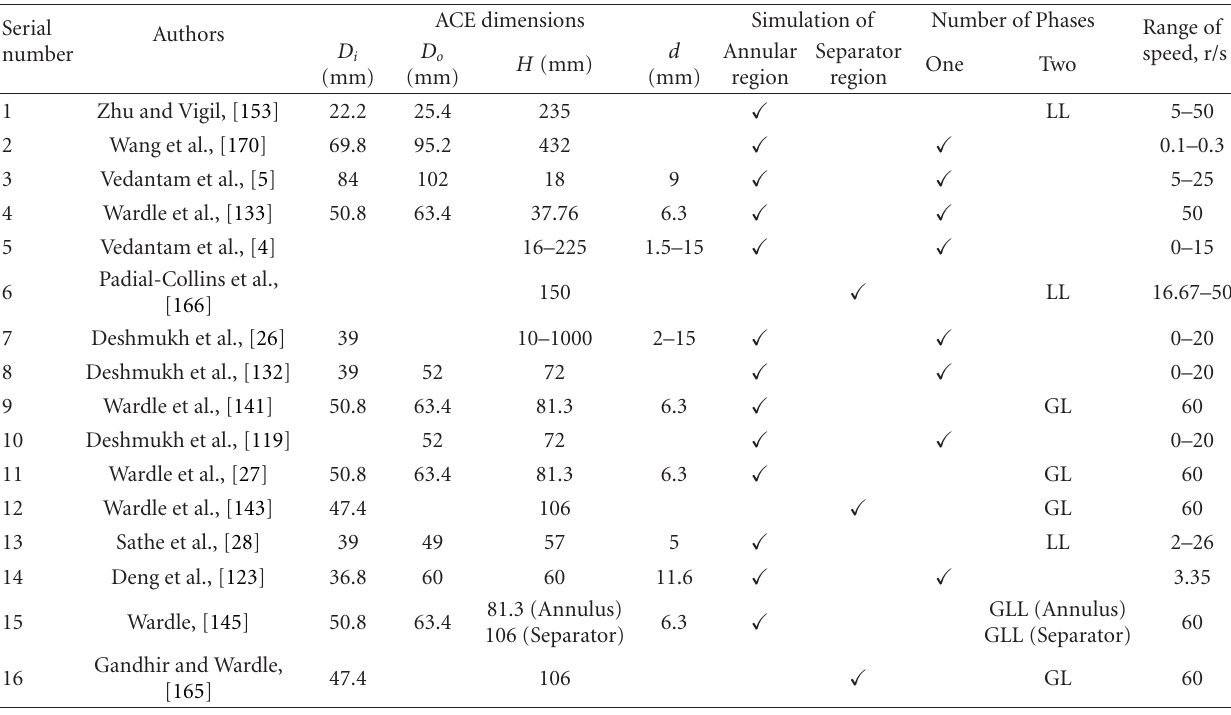
Table 1: Summary of geometric parameters used in the previous